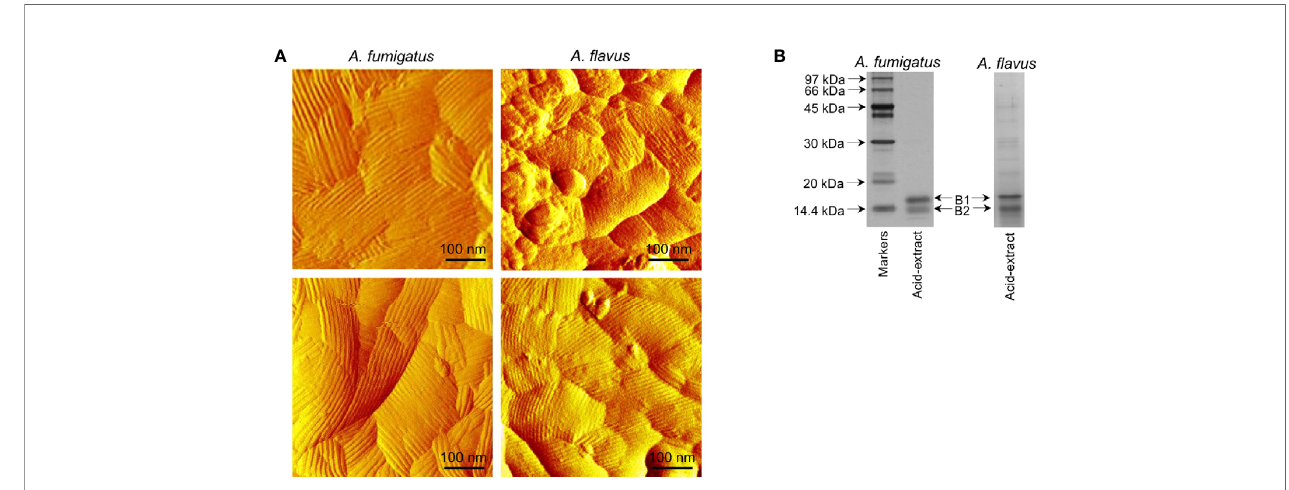
FIGURE 4 | Comparison of the conidial surfaces and extractable proteins from the conidial surface of A. fumigatus and A. fl avus . (A) Atomic force microscopy images of the conidial surfaces acquired in liquid conditions. Conidial surface of A. fumigatus is uniformly covered by rodlet layer, whereas amorphous material was observed along with the rodlets on A. fl avus conidial surfaces. (B) SDS-PAGE pro fi les of the conidial formic acid-extracts showing two isoforms of RodA [B1 and B2, with experimentally determined molecular weights of 16 kDa (B1) and 14.5 kDa (B2),